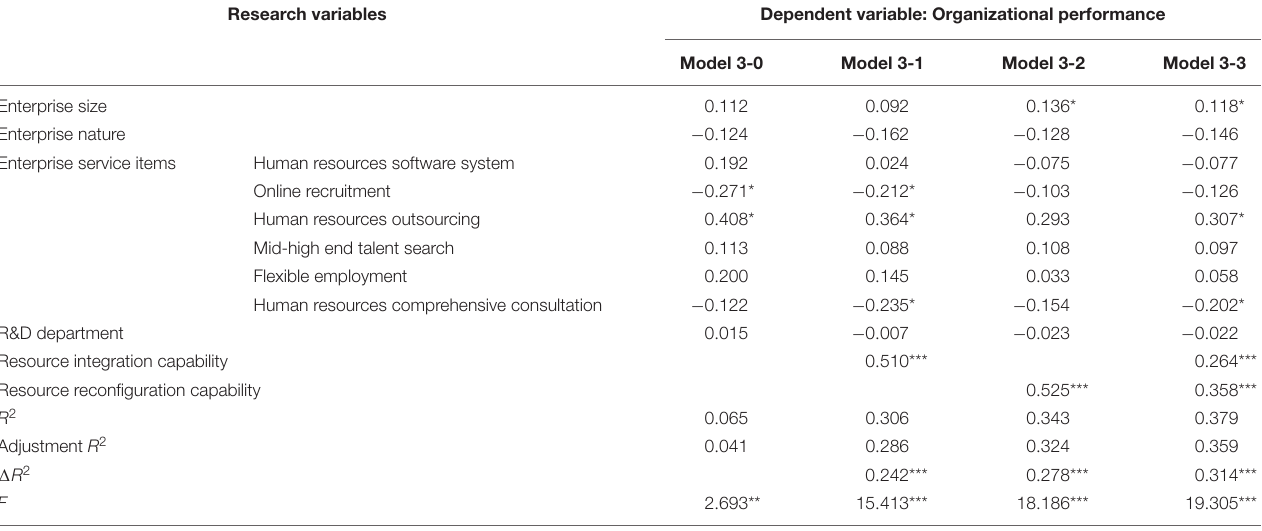
TABLE 7 | Regression analysis results of dynamic capability on organizational